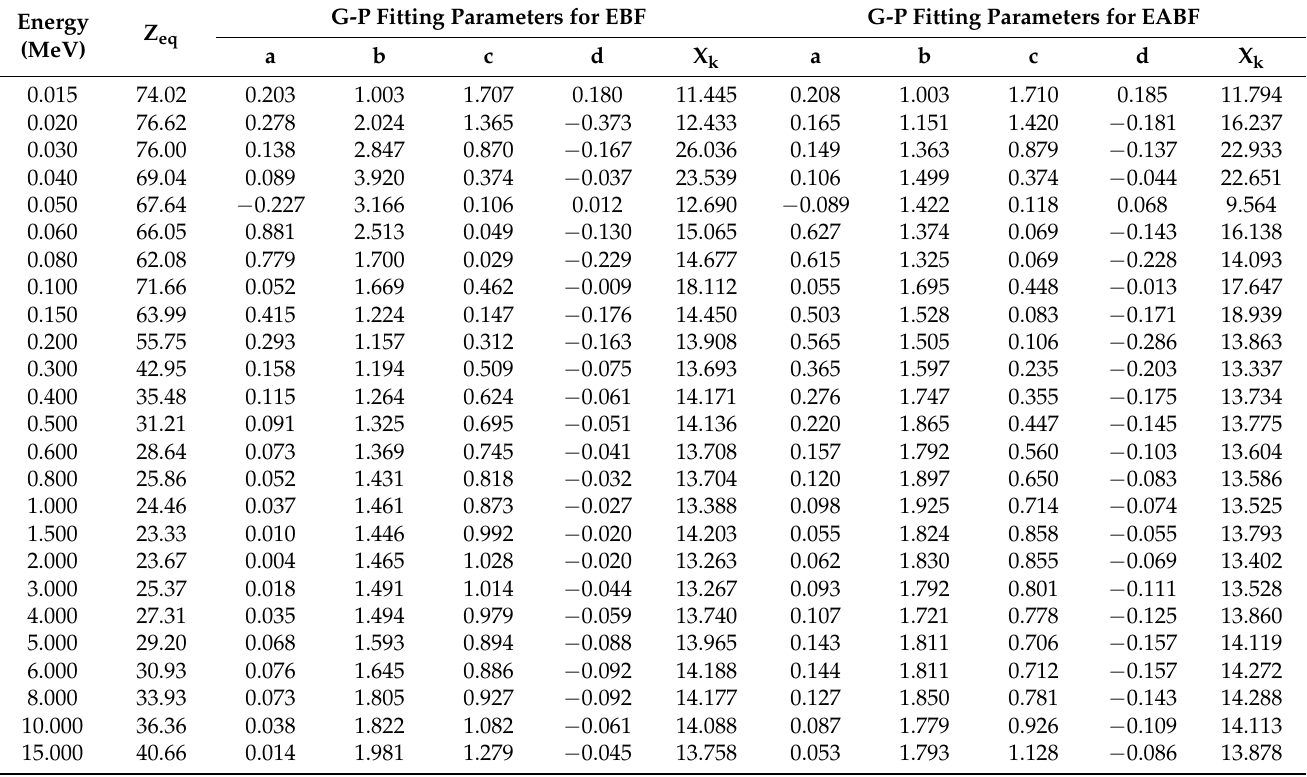
Table 4. (EBF and EABF) G–P fitting coefficients (b, c, a, Xk and d) of LPb50Eu0.5 glass